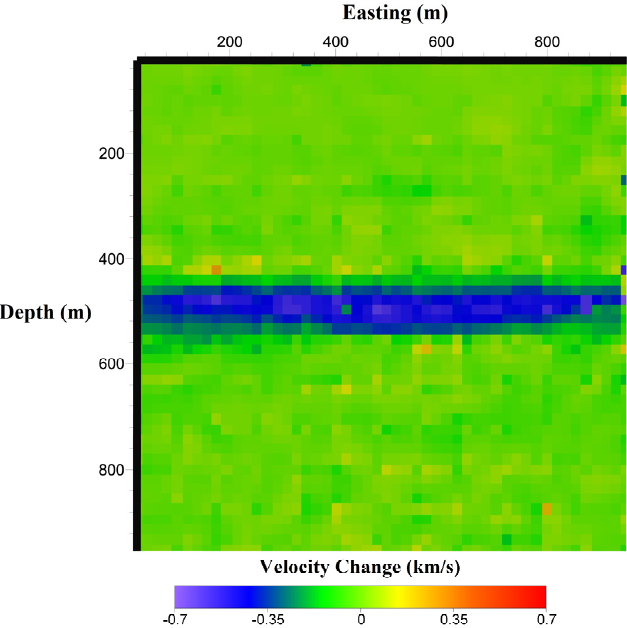
Figure 7. Tomogram of the change in velocity for the first synthetic test, using the velocity model in Figure 6a.